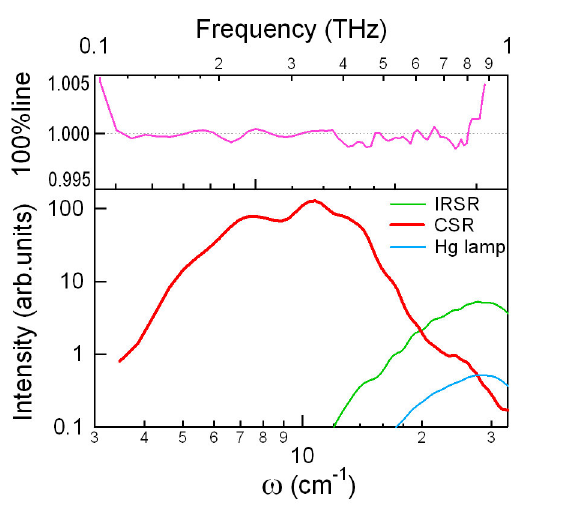
Figure 4: Comparison of fluxes in the far IR/THz range. Running BESSY II in the low- α mode yields coherent synchrotron radiation (CSR) at the IRIS beamline with fluxes several orders of magnitudes higher than obtained with incoherent infrared synchrotron radiation (IRSR) or with internal spectrom- eter sources (Hg lamp). An rms noise of better than 0.1% is achieved from the CSR source as indicated by the 100% line, the ratio of two subsequently recorded spectra. Data were taken in vacuum using a Bruker 66/v spectrometer (Schade et al.,